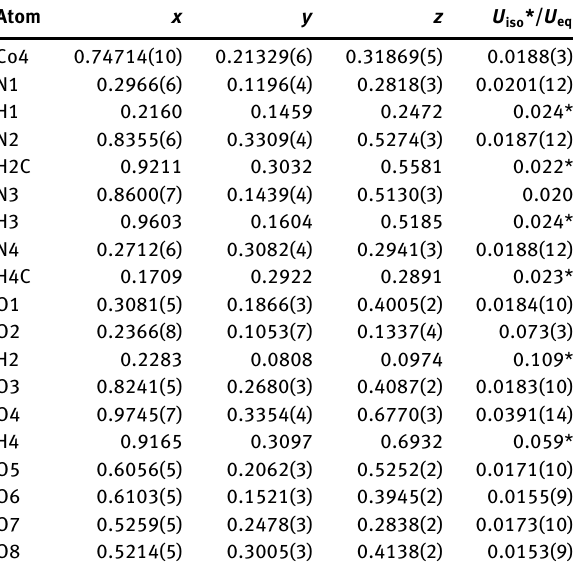
Table 2: Fractional atomic coordinates and isotropic or equivalent isotropic displacement parameters (Å 2